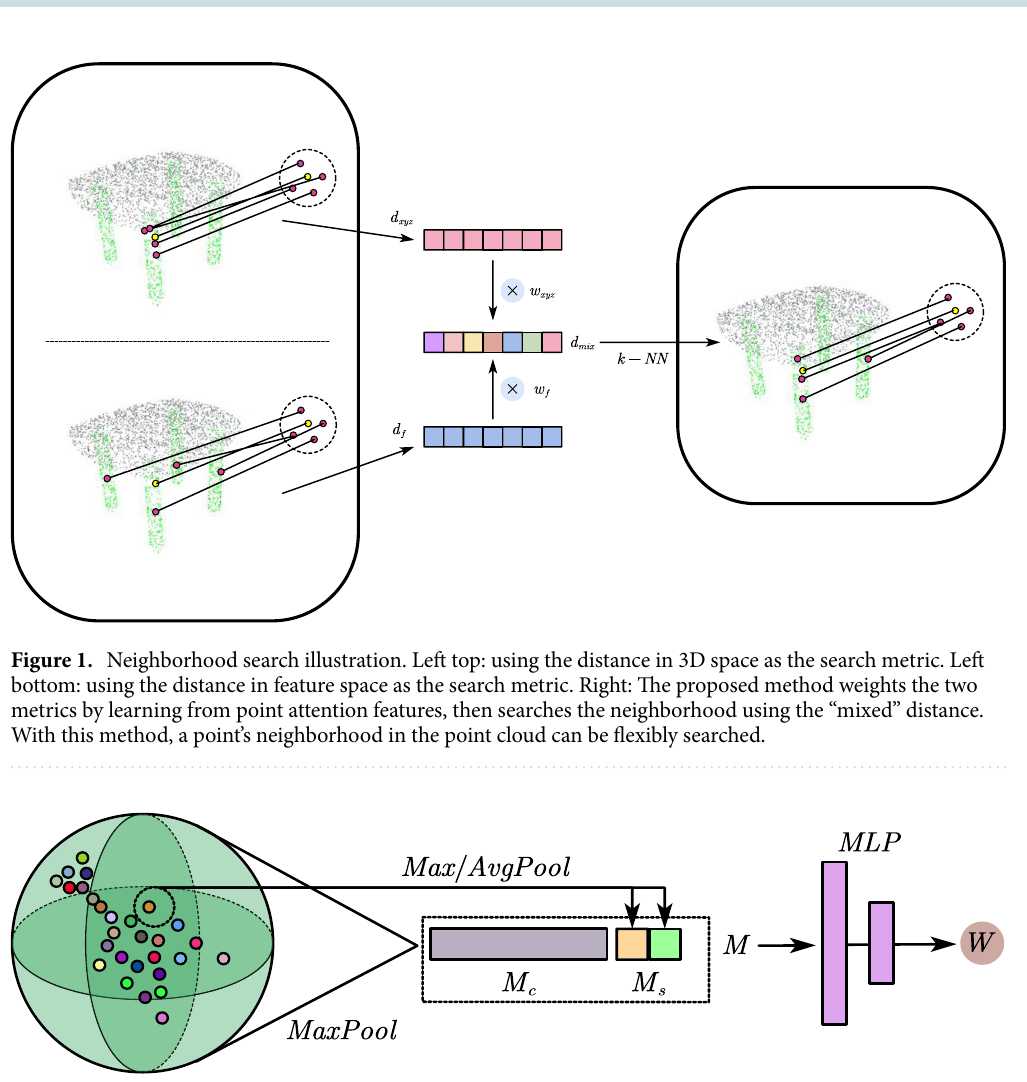
Figure 2. Generation of w d and w s from point cloud features. M c is the global descriptor of the point cloud, and M s is the point’s local feature. The point attention feature is obtained by concatenating M c and M s . Then, an MLP layer is used to generate w d and w s , and softmax is used to normalize the